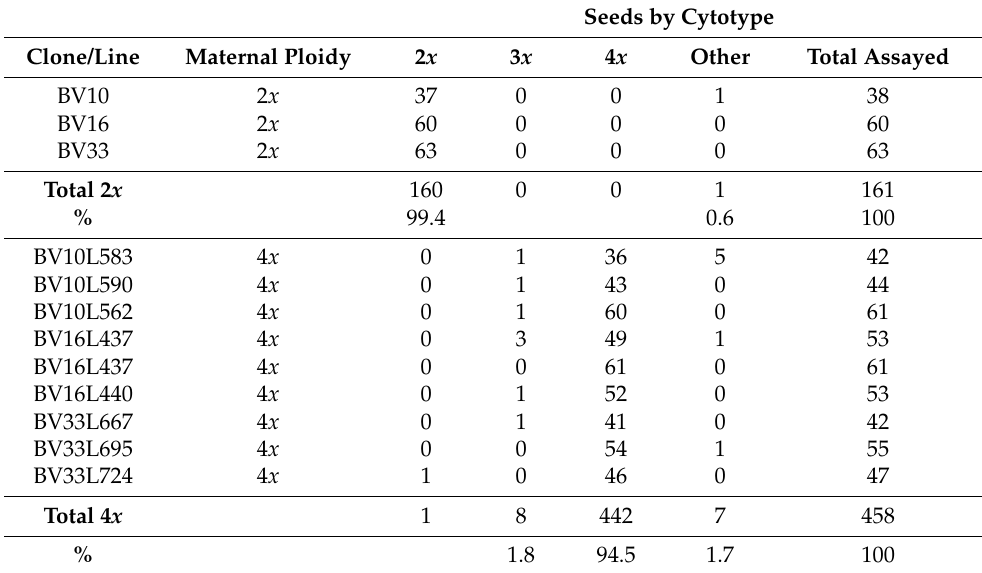
Table 5. Ploidy determination for open pollinated seed harvested from 2 x and 4 x lines in the Bau Bang trial during 2014.